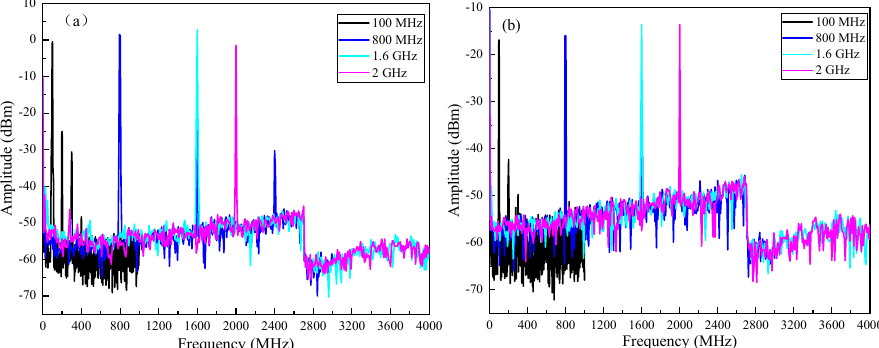
Figure 5. Spectrum of the modulation ( a ) before and ( b ) after amplification.